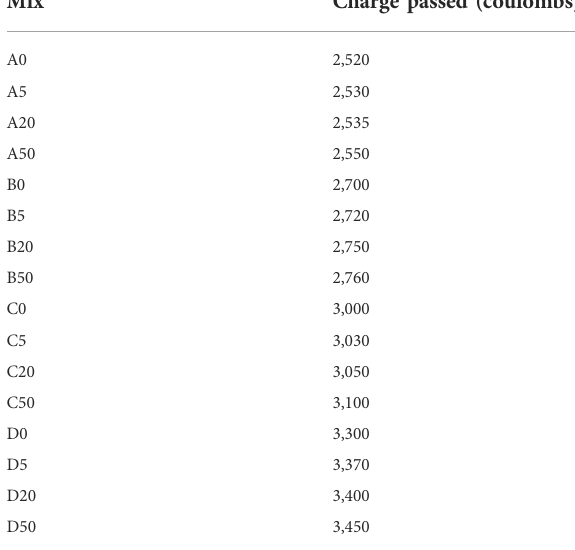
TABLE 4 Chloride